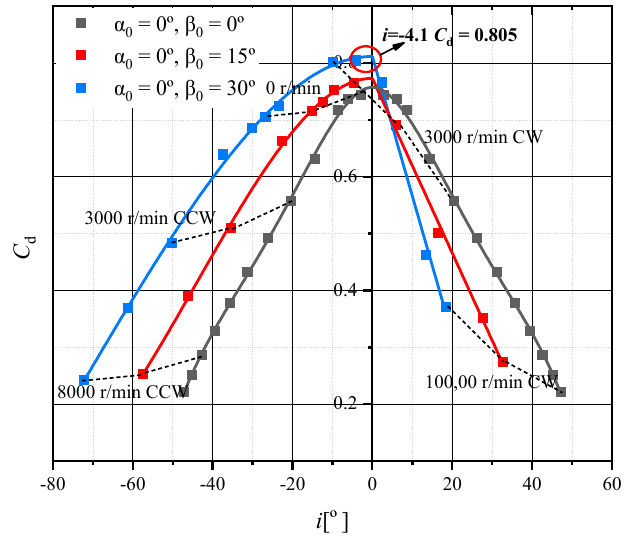
Figure 16. Relationship between 𝐶 d and i under different circumferential inclination angles (0°, 15°, and 30°).